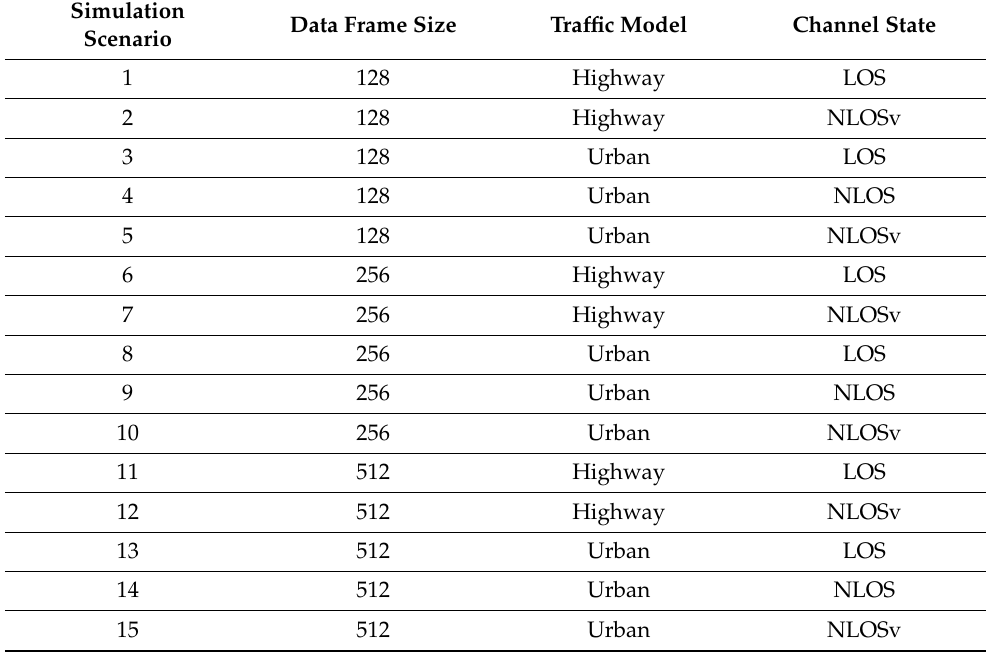
Table 6. Simulation